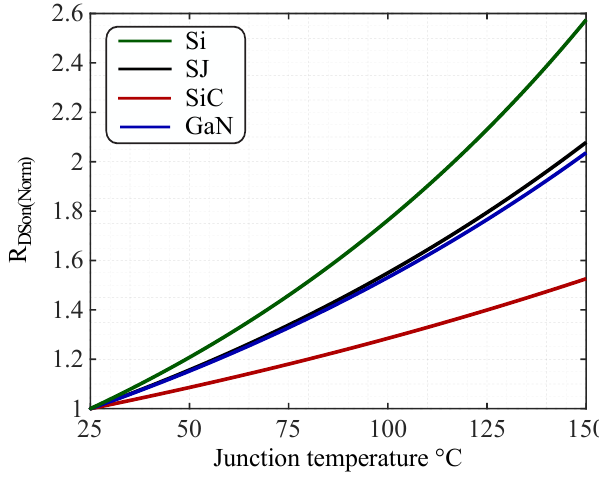
Figure 5. R DSon normalized for each technology × T J